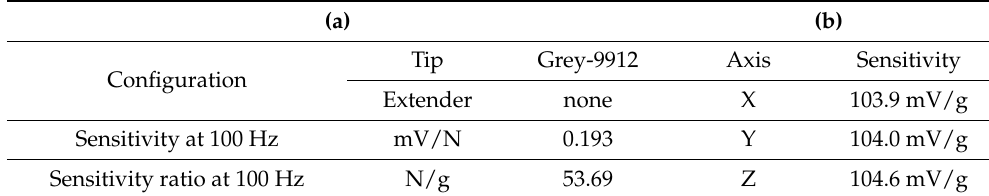
Table 7. Sensitivity configuration: (a) hammer and (b) accelerometer sensor.